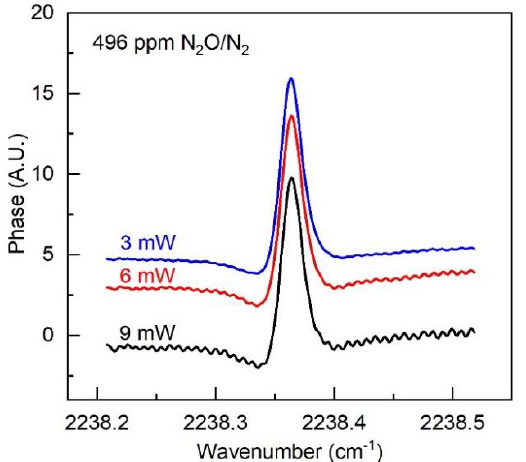
Figure 5. Measured HPSDS phase signals at different optical power levels for the same N 2 O concentration (496 ppm). The three signals are shifted vertically for viewing purposes.